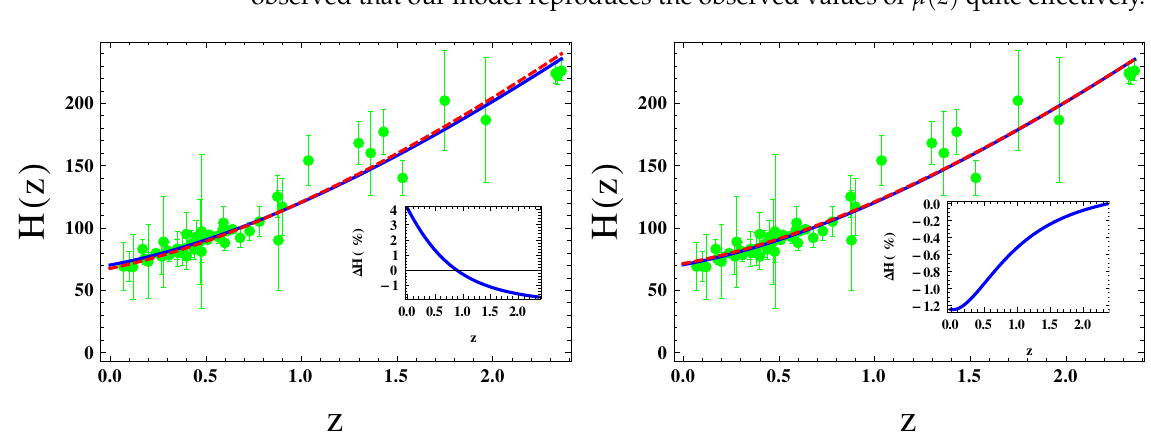
model (red line) are plotted in Figure 2. The 580 points of Supernovae Type Ia datasets (black dots) are also plotted in Figure 2 for comparision. From this figure, it has been observed that our model reproduces the observed values of µ ( z ) quite effectively.